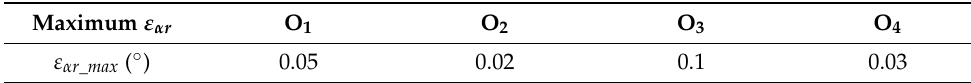
Table 2. Maximum remaining errors after calibration using five error terms.